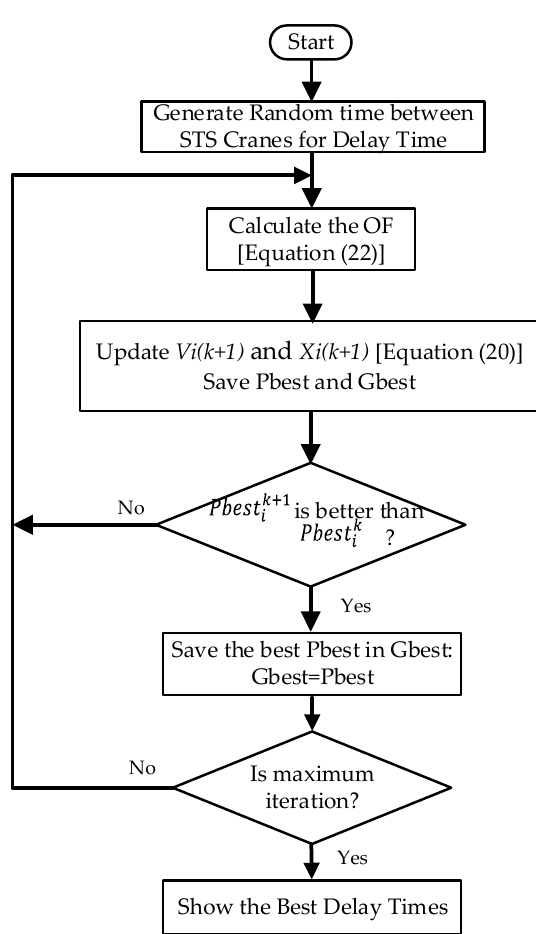
Figure 13. Particle swarm optimization (PSO) flowchart for power demand optimization in the STS crane group. Table 5. Rated Pmax in di ff erent scenarios for the group of STS cranes